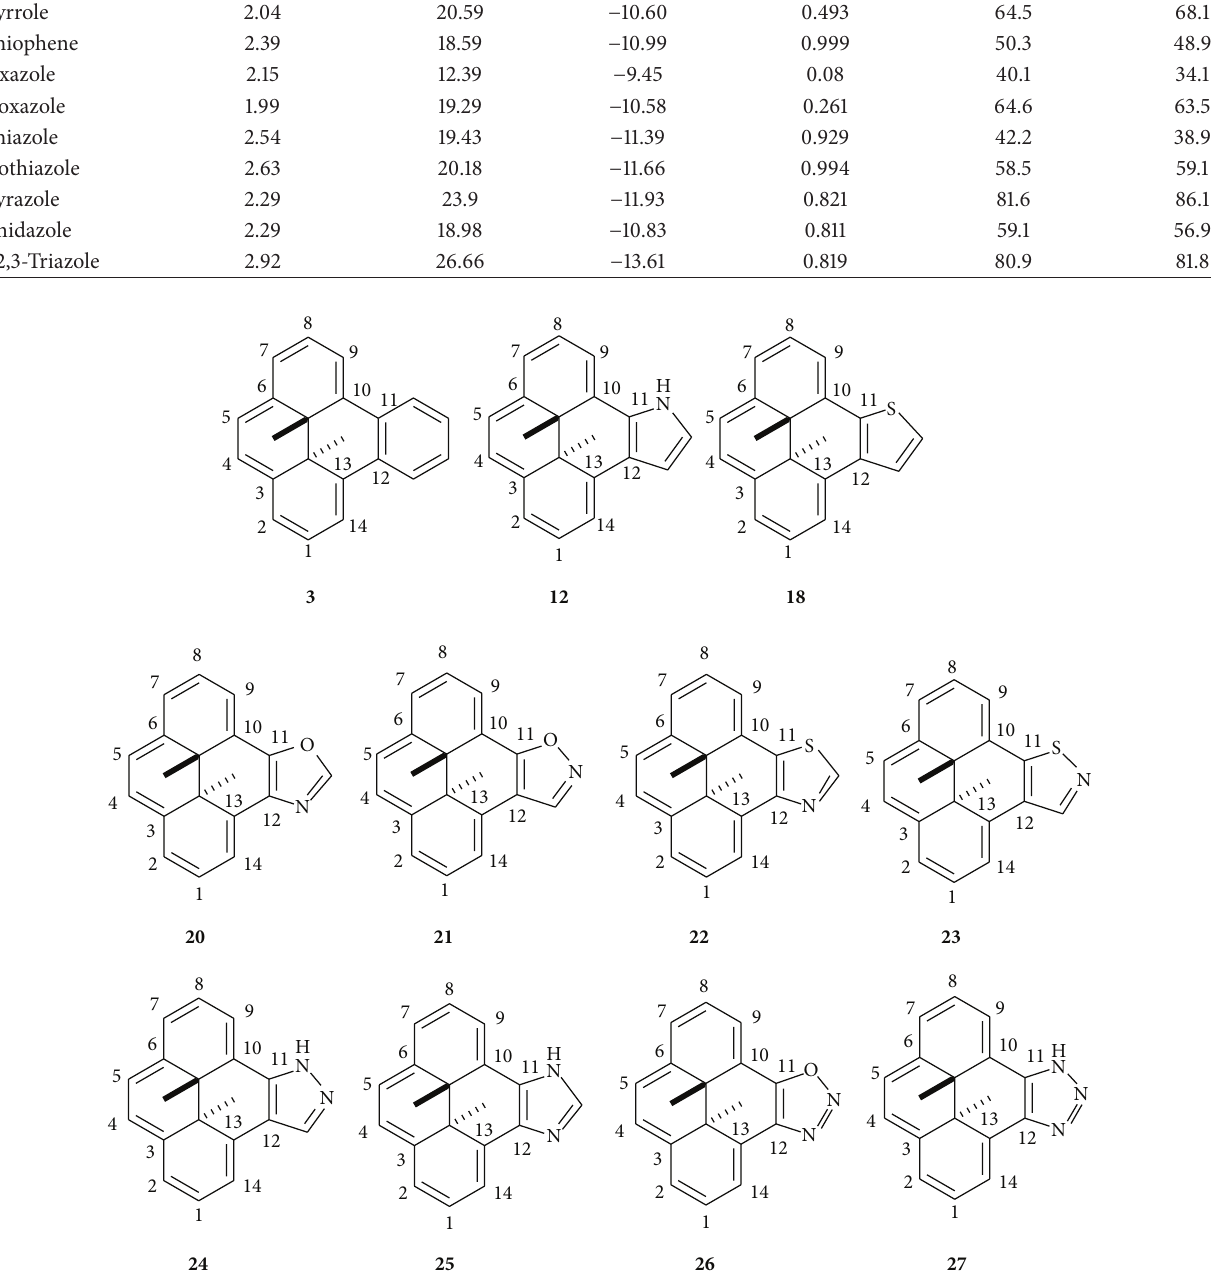
Figure 7: Numbering scheme of dihydropyrene skeleton for benzene and heterocycles fused